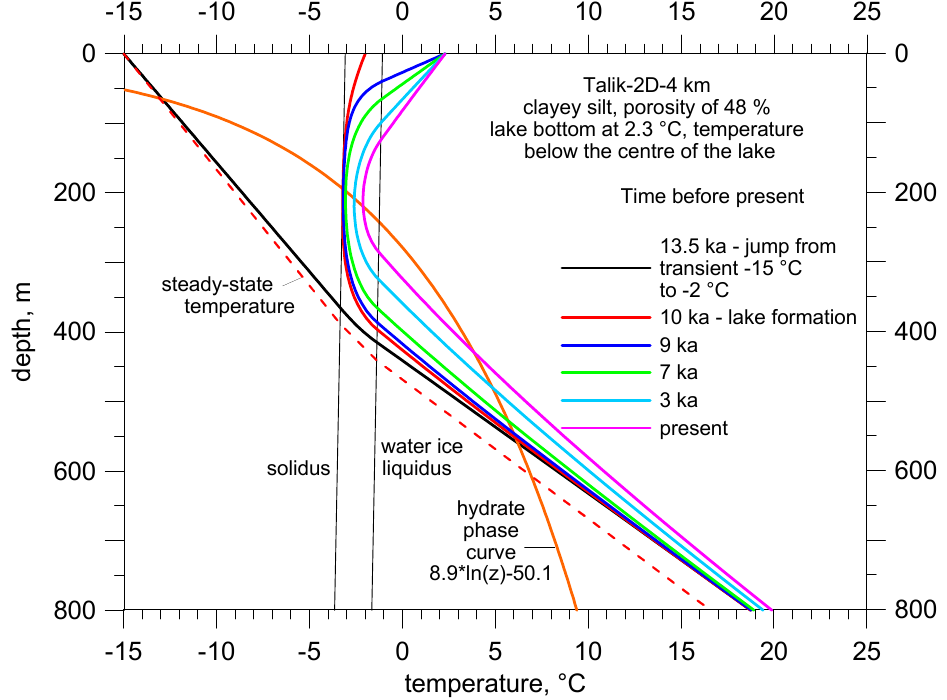
Figure 9. T – z profiles for the center of the lake at its formation 10 ka ago, and at 9 ka ago, 7